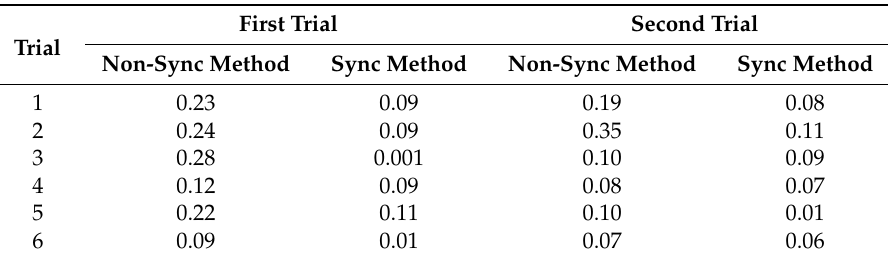
Table 2. Uncoded bit error rate at 2 knots.